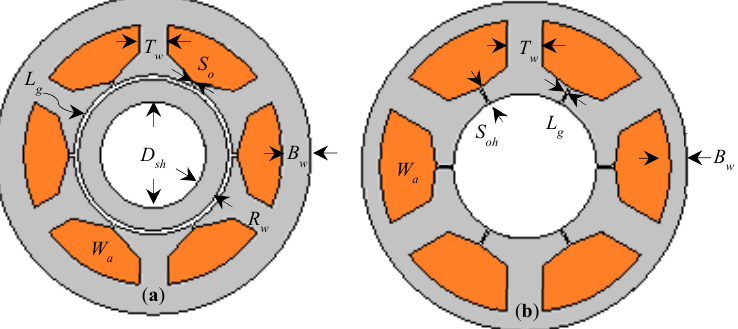
Figure 3. Integrated Inductors Layout ( a ) Integrated Rotational Inductor ( b ) Integrated Rotor-less Inductor .